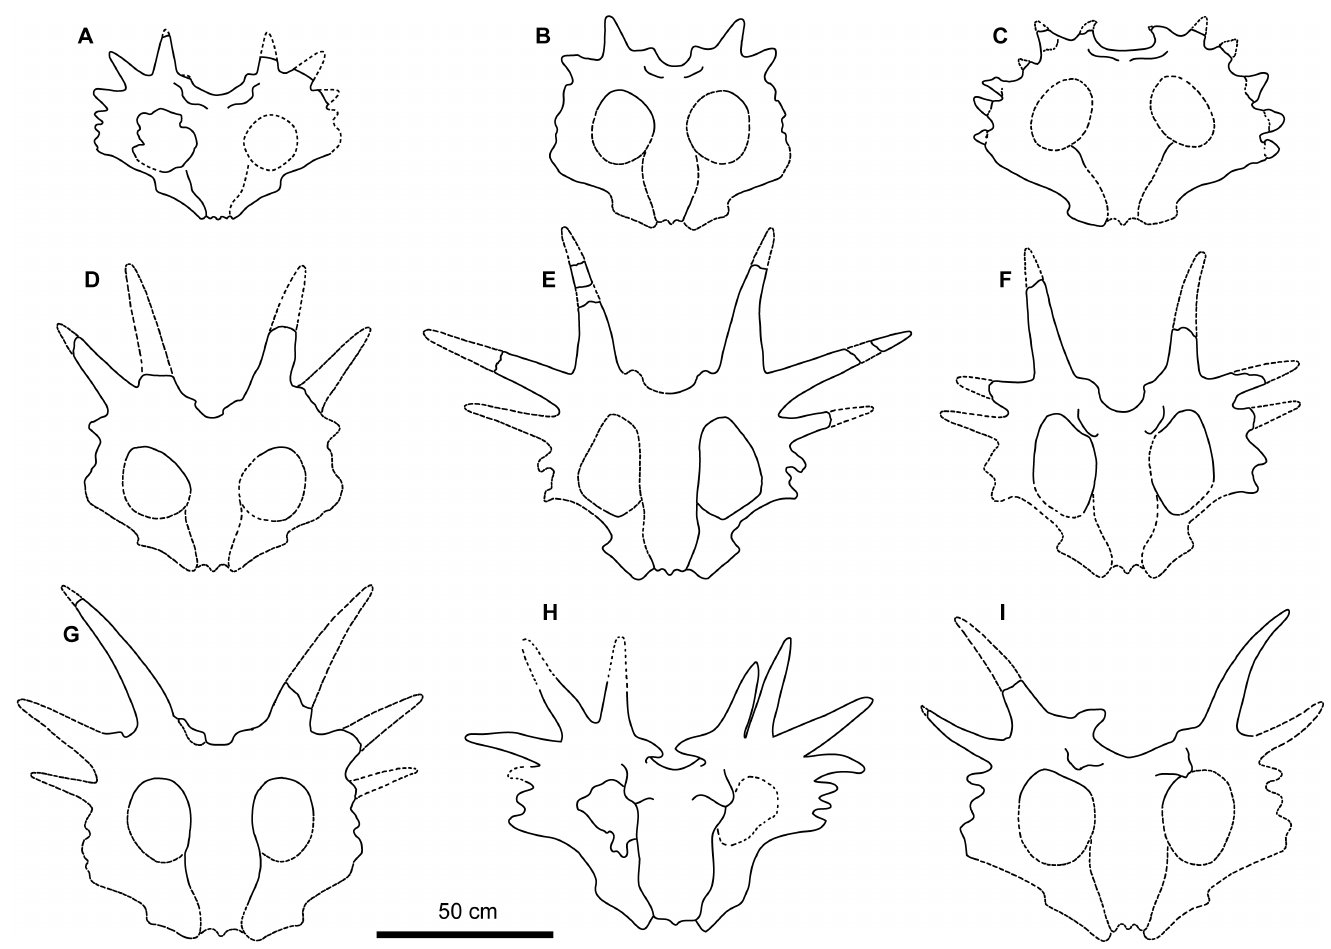
Figure 10. Reconstructed line drawings of the complete or relatively complete parietals of the centrosaurine ceratopsid Styracosaurus albertensis in dorsal (i.e., orthogonal to frill). Specimens are arranged in approximate order of increasing size of parietal ornamentation and size. A, TMP 2009.080.0001. B, TMP 1989.098.0001. C, TMP 1989.126.0001. D, TMP 1988.036.0020. E, CMN 344. F, TMP 2005.012.0058. G, TMP 1987.052.0001. H, UALVP 55900. I, ROM 1436. Based on develop- ment of the parietal ornamentation A−C represent subadult specimens, whereas D−I are regarded as largely skeletally mature. Scale bar = 50